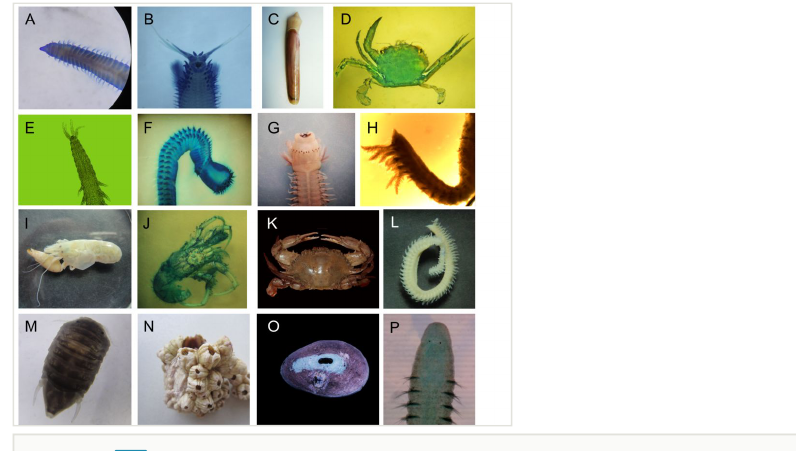
Figure 2. Species of invertebrates from central coast of Peru in the in fl uence area of PERU LNG marine terminal. A. Cossura chilensis , B. Diopatra chiliensis , C. Ensis macha , D. Cronius ruber , E. Goniadides falcigera , F. Nephtys impressa , G. Pseudonereis gallapagensis , H. Paraprionospio pinnata , I. Synalpheus spinifrons , J. Pagurus villosus , K. Arenaeus mexicanus , L. Scolelepis chilensis , M. Ancinus panamensis , N. Balanus laevis , O. Fissurella latimarginata , P. Protoariciella uncinata